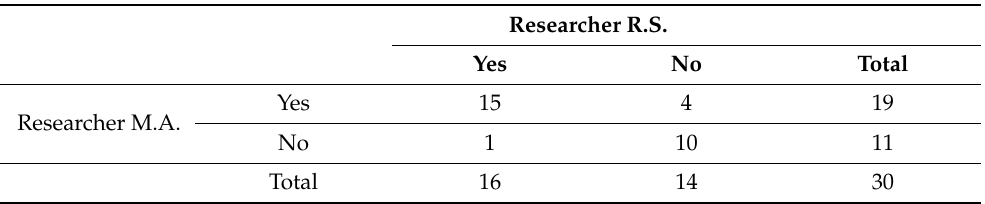
Researcher R.S. Yes No Total